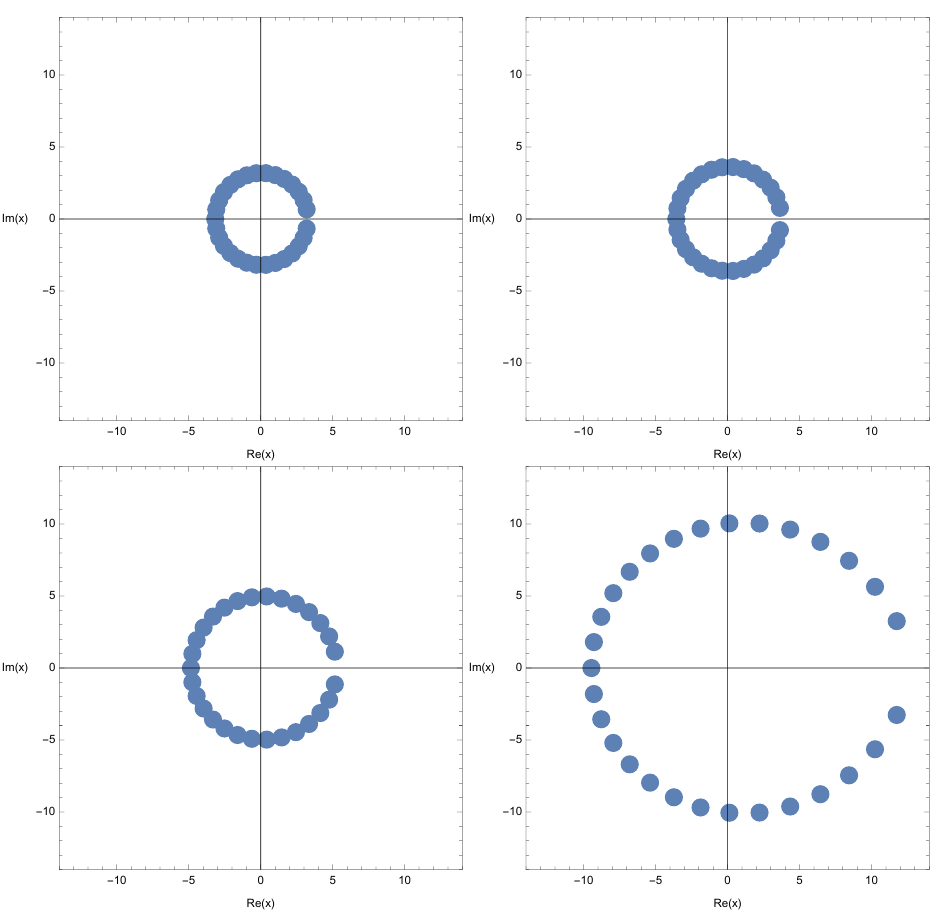
Figure 4. Stacking structure of approximation roots in ( p , q ) -sine geometric polynomials when n = 30, p = 9